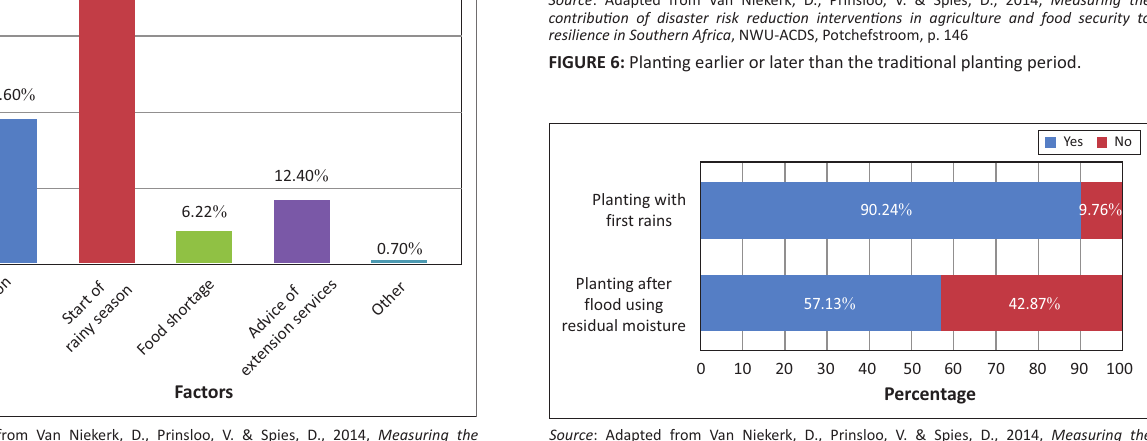
FIGURE 7: The timing of